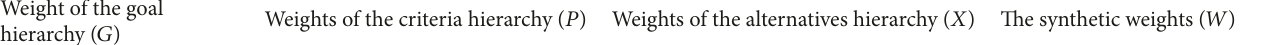
Table 5: The results of the weights in the hierarchical